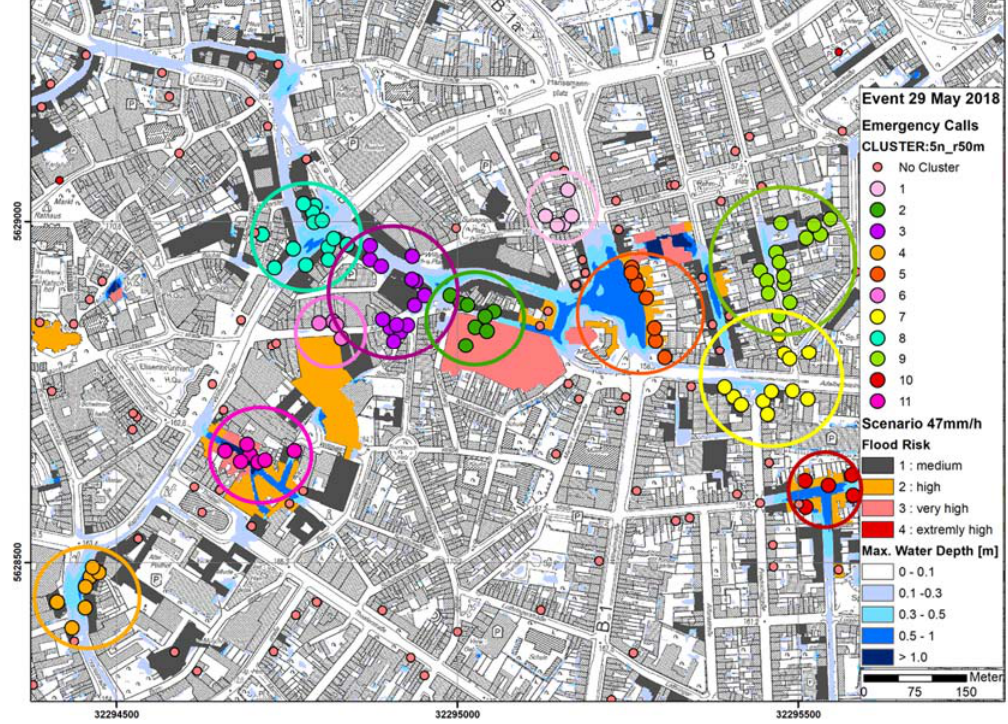
Figure 5. Zoom-in of a systematic risk analysis and clustered hotspots in a 100 years scenario (47 mm / h) and hotspot clustered emergency calls during the May event 2018 in the center of Aachen.